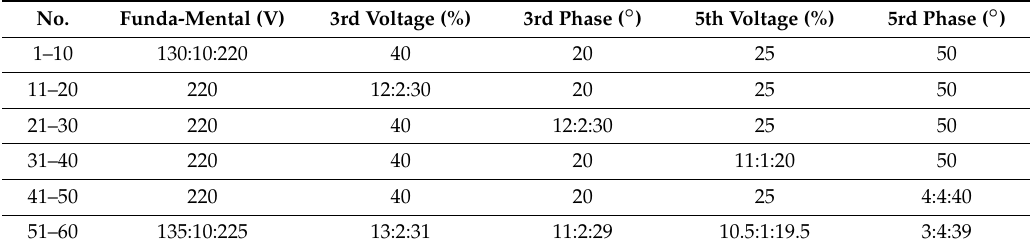
Table 2. Changing harmonic voltage components in 60 simulations.